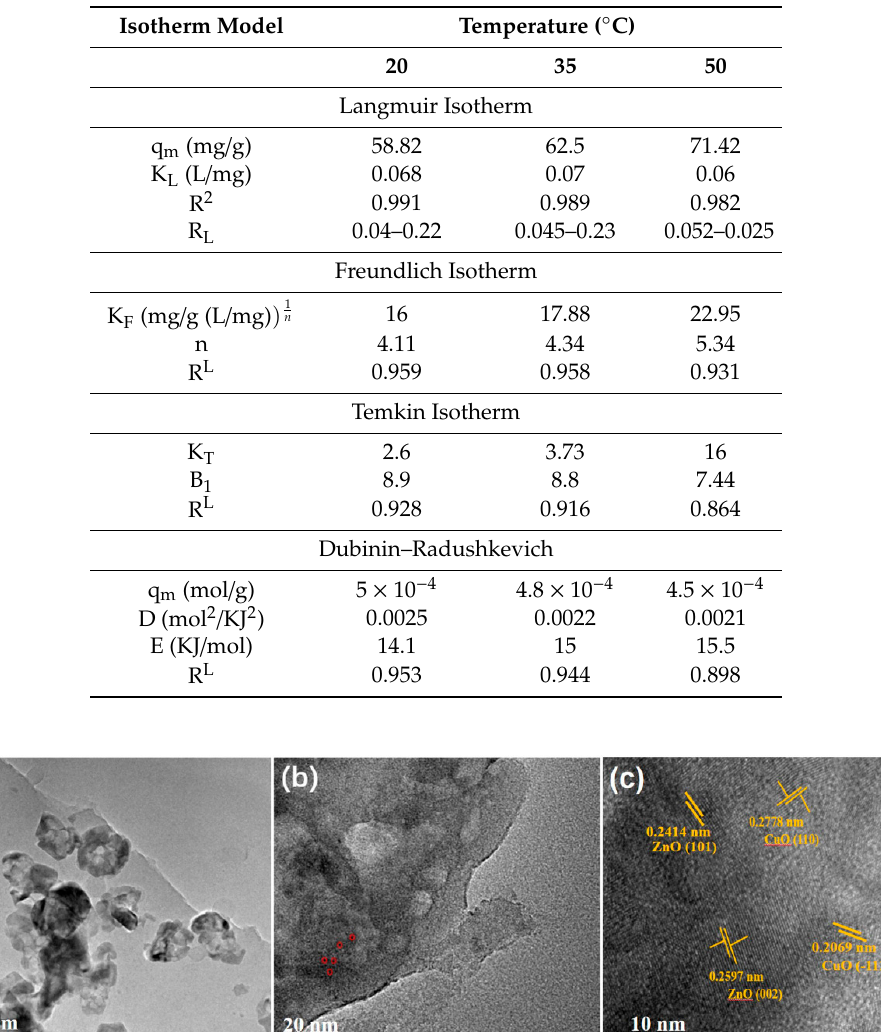
Table 3. Adsorption isotherm model parameters of Pb 2 + adsorption onto Fe 3 O 4 @C at di ff erent temperatures. Reproduced [67] with permission from Wiley-VCH,